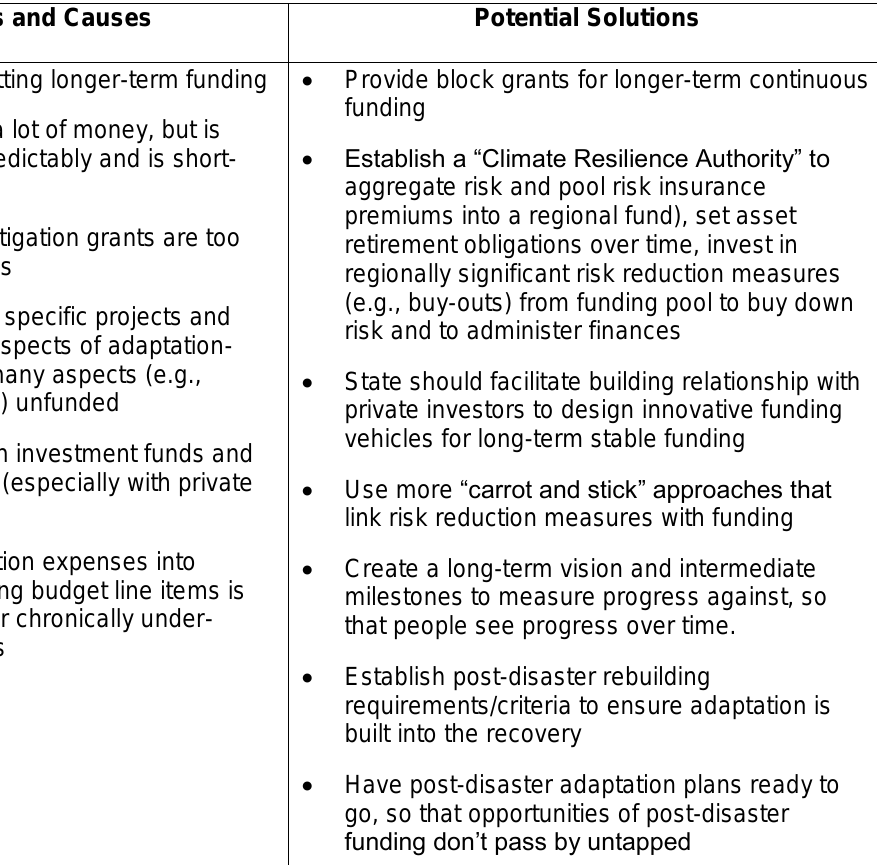
Table A2.11: Characteristics, Underlying Causes and Potential Solutions to